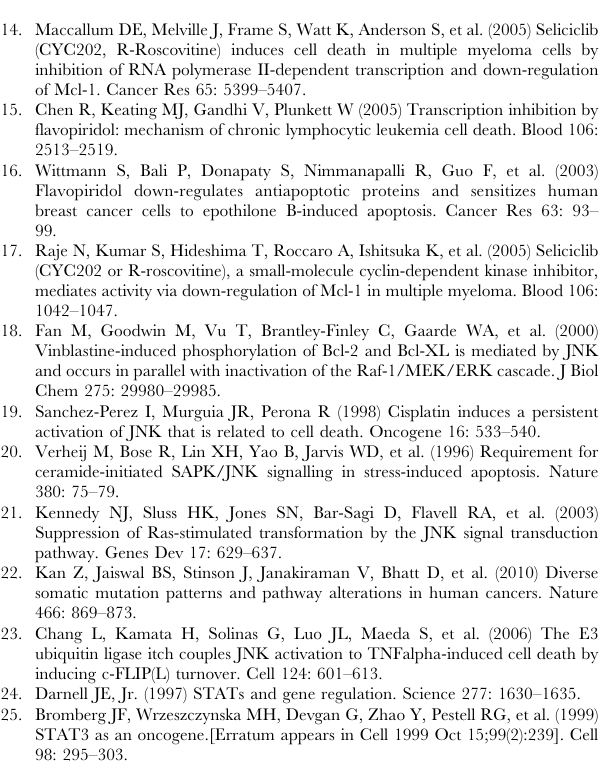
Figure S1 Body weights of mice treated with NSC- 743380 or NSC-741909. Data presented are the mean body weights of mice shown in Figure 2. The mice bearing subcutaneous A498 renal tumor xenografts were treated with vehicle control, NSC-743380 or NSC-741909 at the doses as indicated. Each treatment group had 8 mice while the control group 16 mice. Figure S2 mRNA levels of Cyclin D1 and Cyclin B1 expression after treatment with NSC-743380. A) Time dependent and dose response changes of Cyclin D1 mRNA after treatment with NSC-743380 in A498 cells. B) Dose dependent changes of Cyclin B1 mRNA after treatment with NSC-743380 in